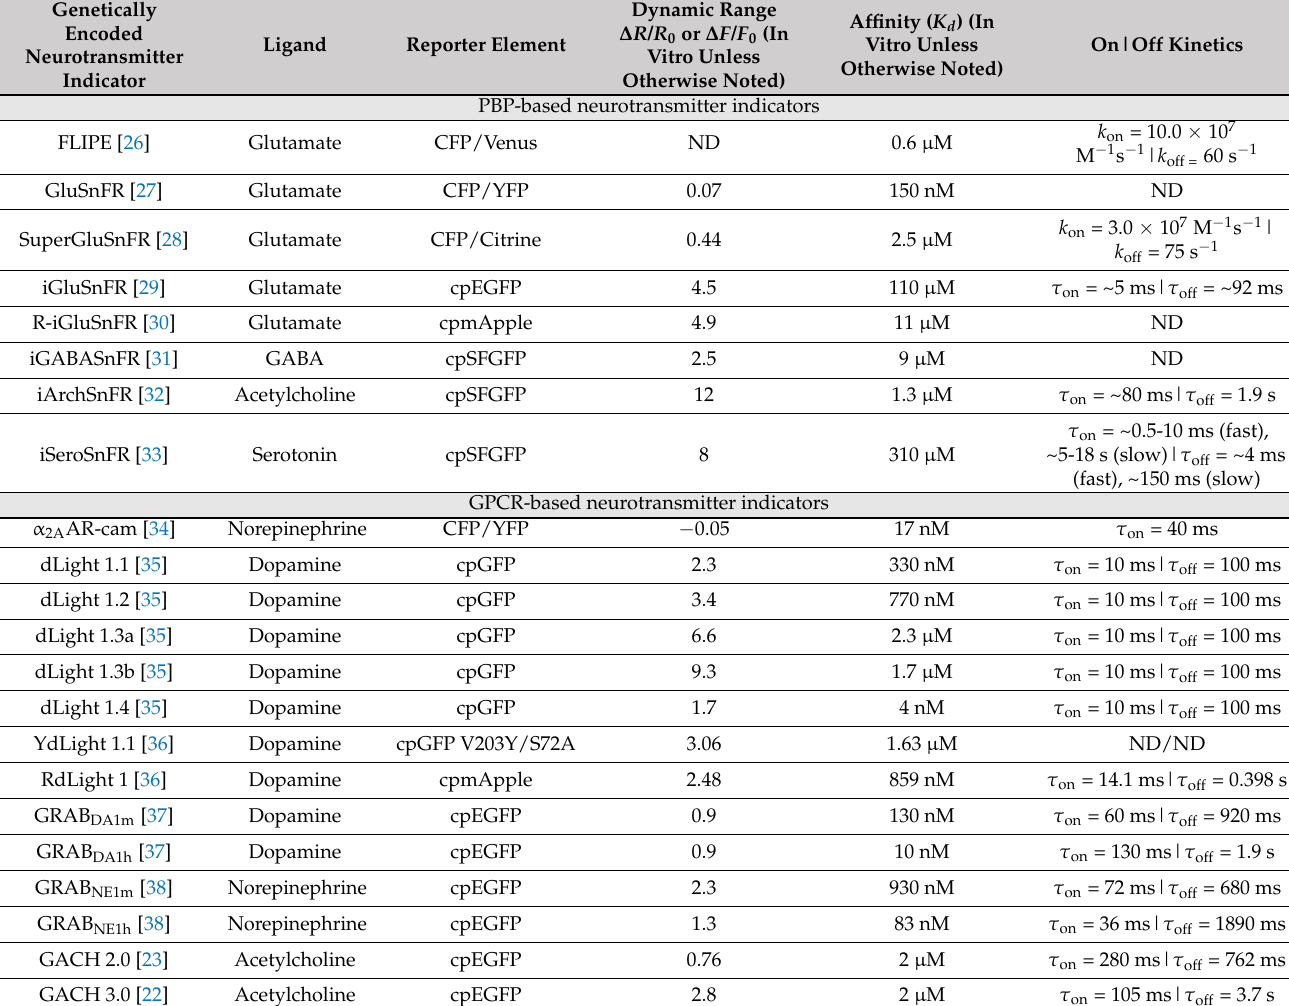
Table 1. Key metrics of selected genetically encoded neurotransmitter